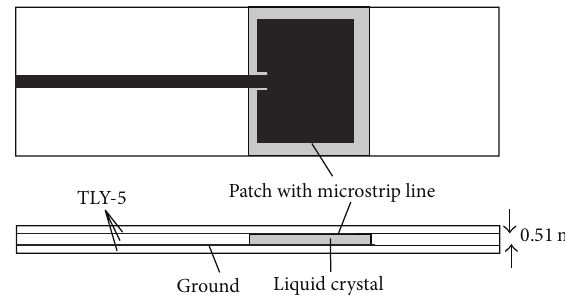
Figure 20: LC tunable microstrip patch antenna [36].